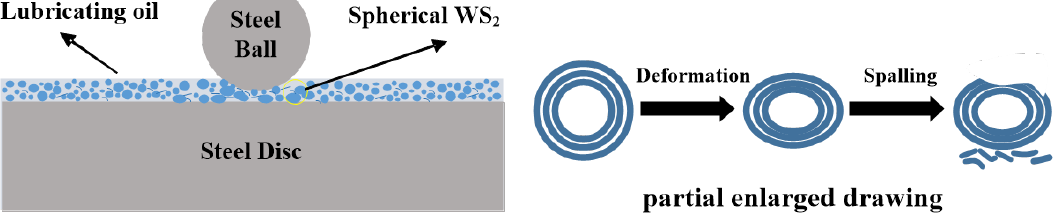
Figure 14. Lubrication mechanism of spherical WS 2 as lubricating oil additive. (Left: overall schematic) (right: schematic details).